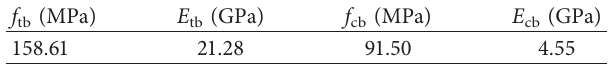
Table 3: Material properties for bamboo scrimber.